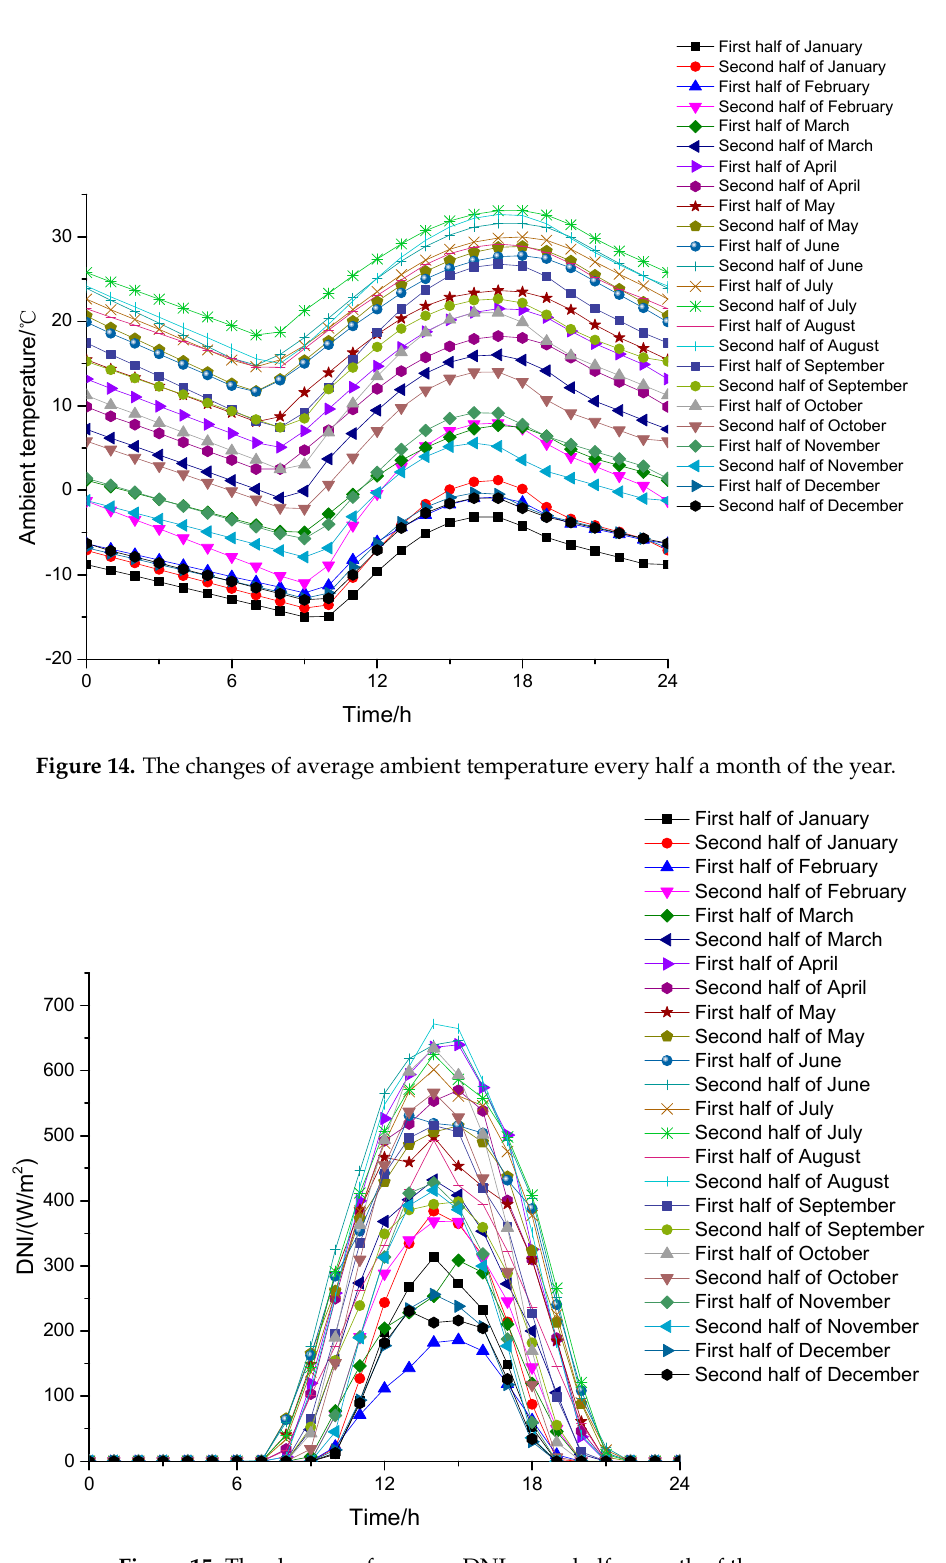
Figure 15. The changes of average DNI every half a month of the year.